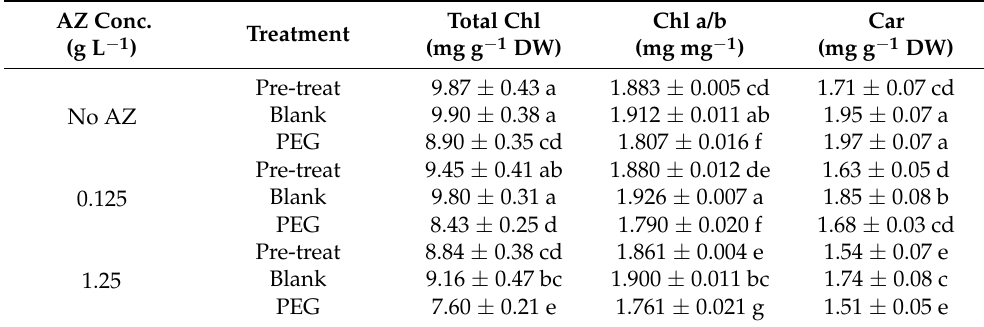
Table 2. Change in total chlorophylls (Chl), Chl a / b , and carotenoids (Car) in tea leaf discs with pre-treatment (Pre-treat) of three different azoxystrobin (AZ) levels followed by treatment with a blank solution (Blank) and PEG-induced osmotic stress (PEG), respectively. AZ